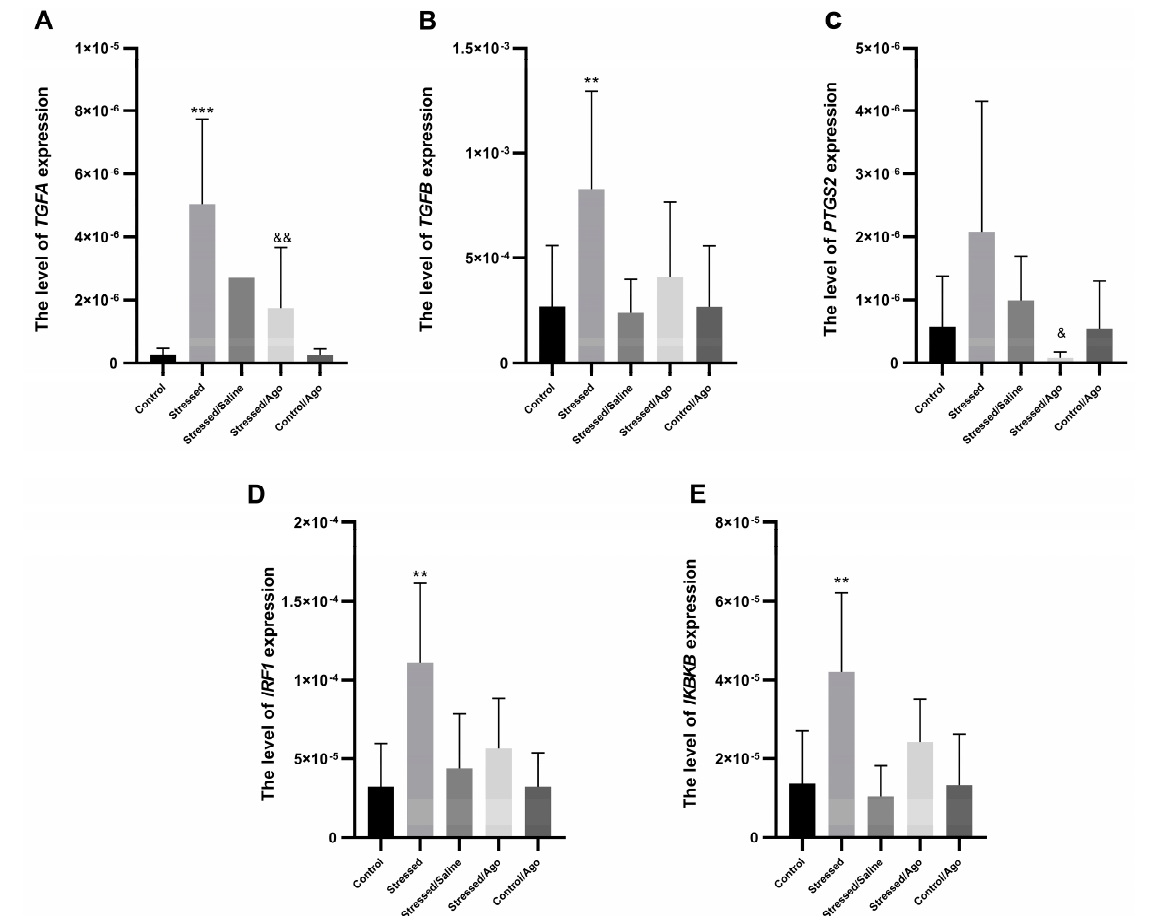
Figure 1. mRNA expression of TGFA ( A ), TGFB ( B ), PTGS2 ( C ), IRF1 ( D ) and IKBKB ( E ) in PBMCs of animals exposed to chronic mild stress (CMS) for two weeks (Control, Stressed) and in animals exposed to CMS for seven weeks and administered vehicle (1 mL/kg) or venlafaxine (10 mg/kg) for five weeks (Stressed/Saline, Stressed/Ago, Control/Ago). Relative gene expression levels were estimated using the 2 − ∆ Ct (Ctgene–Ct18S) method. Data represent means ± SD. N = 6; ** p < 0.01; *** p < 0.001 relative to Control group; & p < 0.05, && p < 0.01 relative to Stressed group. TGFA ( A ):